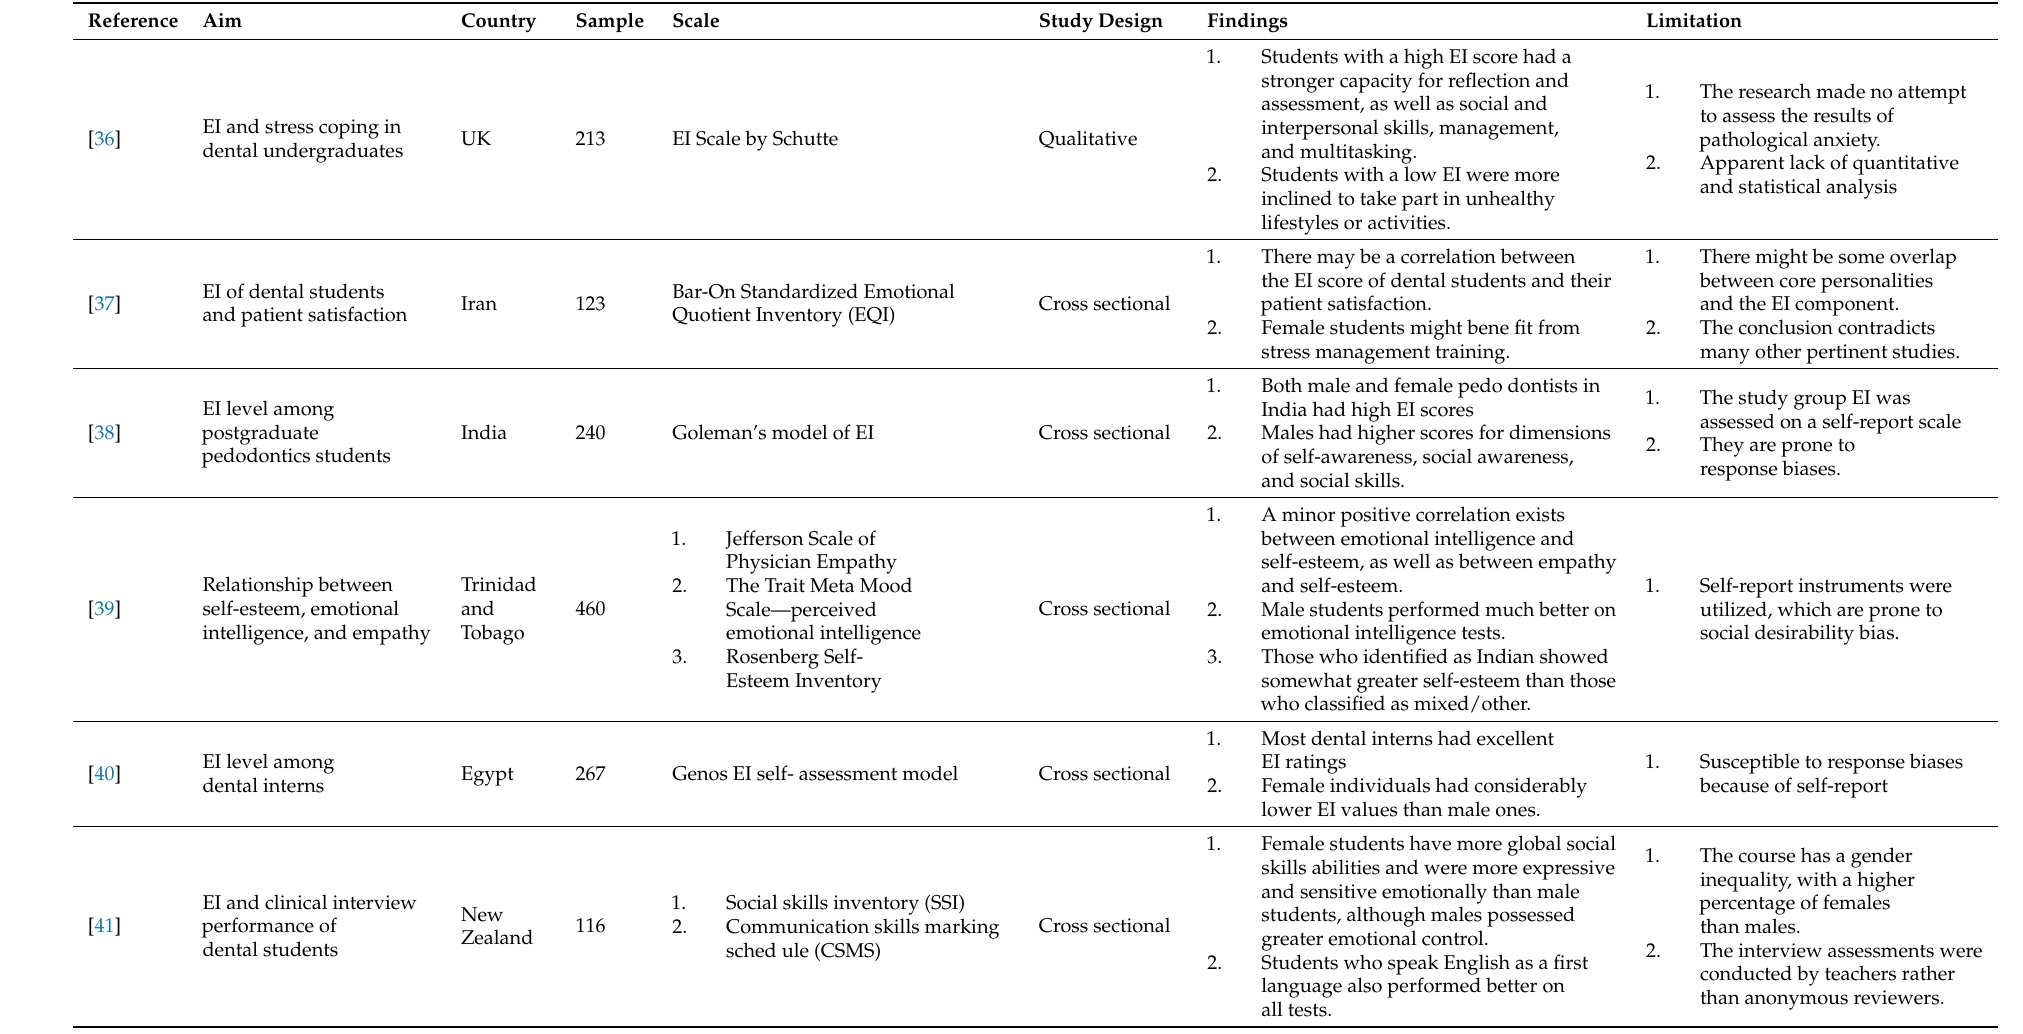
Table 5. Data extraction table (characteristics of the 24 papers included in the review and summary of their